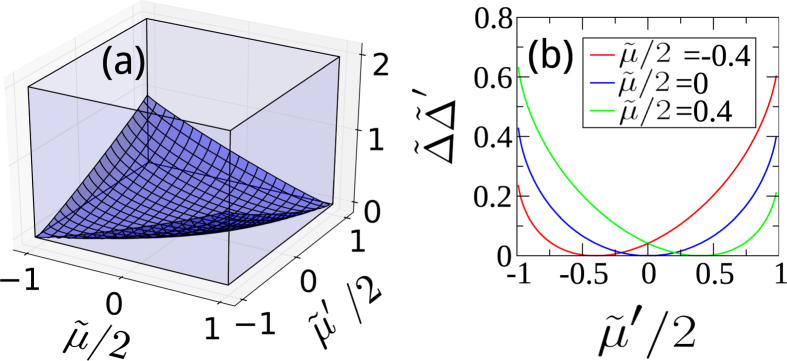
(a) The critical surface in the space of , , and  above which Reff(k) = 0 has no solution. (b) Cross sections of the critical surface at , 0, and 0.4.